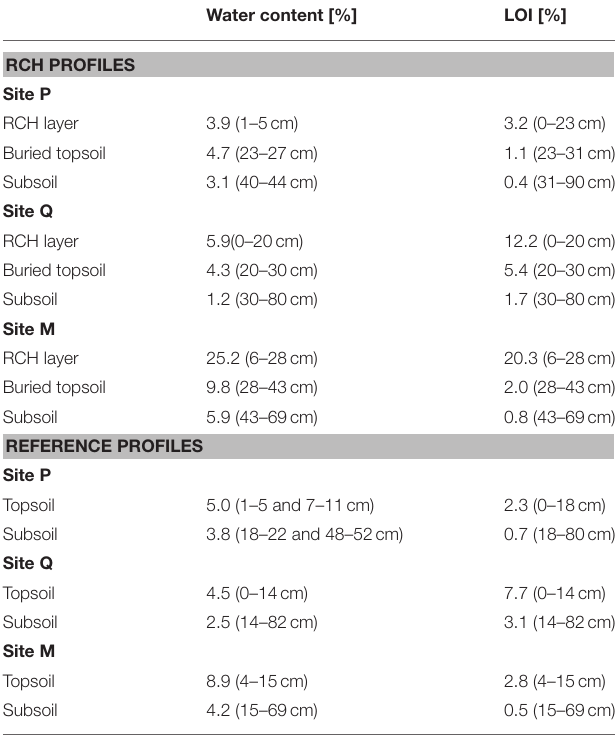
TABLE 1 | Initial water contents at the time of the infiltration experiments and soil organic matter contents as assessed by loss on ignition (LOI) of the profile horizons (determined from bulk samples taken outside of the infiltration plots, except for water content data for profile P, determined as the mean of 5 undisturbed samples from unstained areas within the plot, sampling depths in